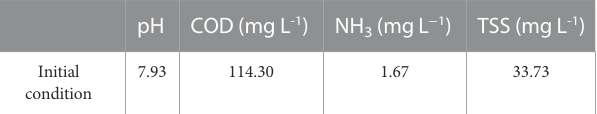
TABLE 1 The initial condition of textile wastewater.